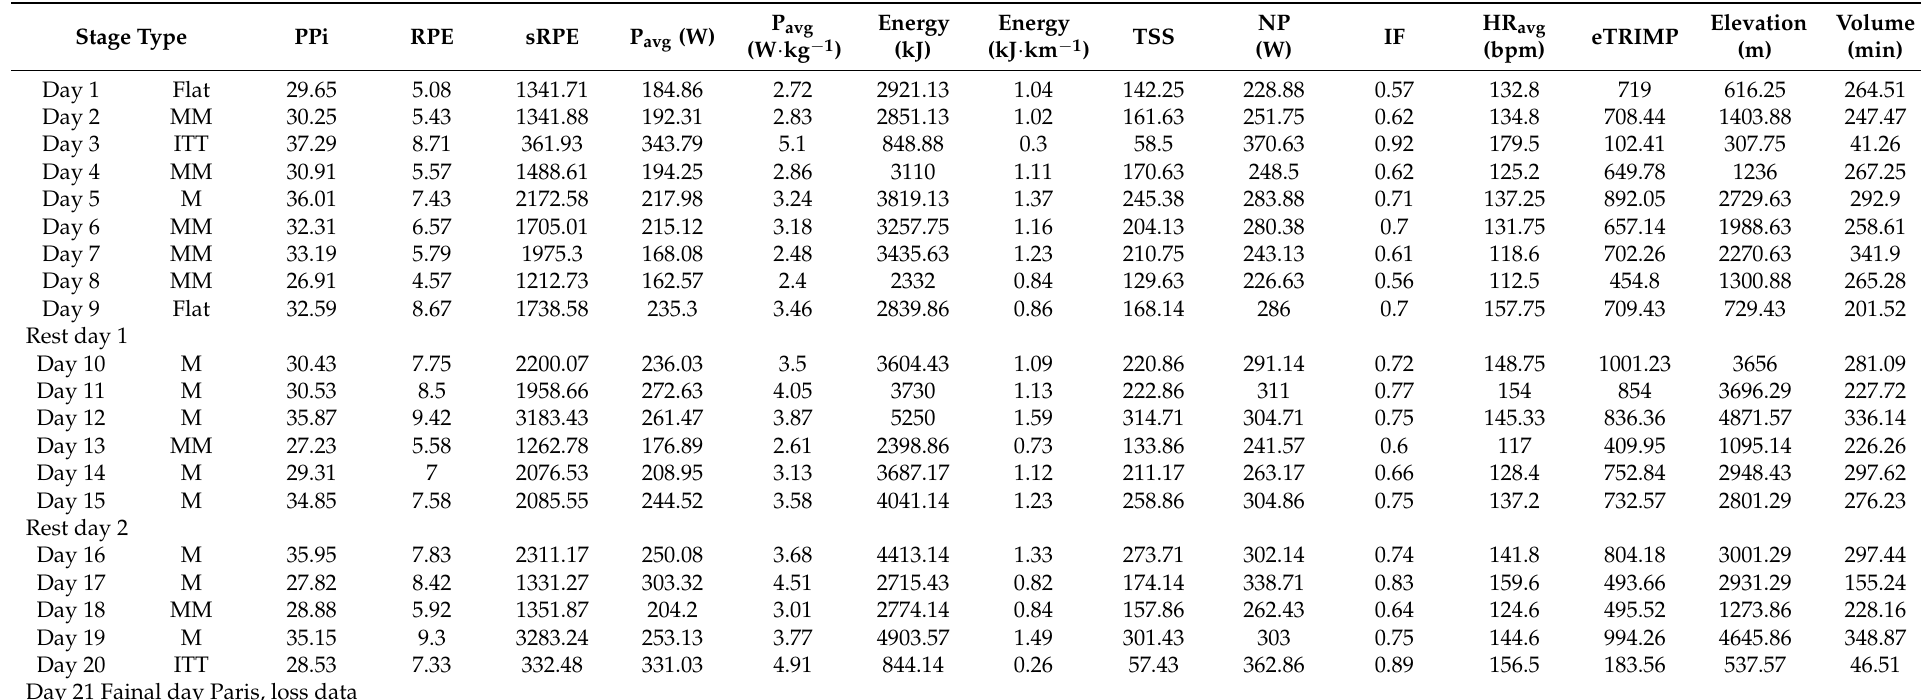
Table 3. Quantification load during 2018 Tour de France ( n =